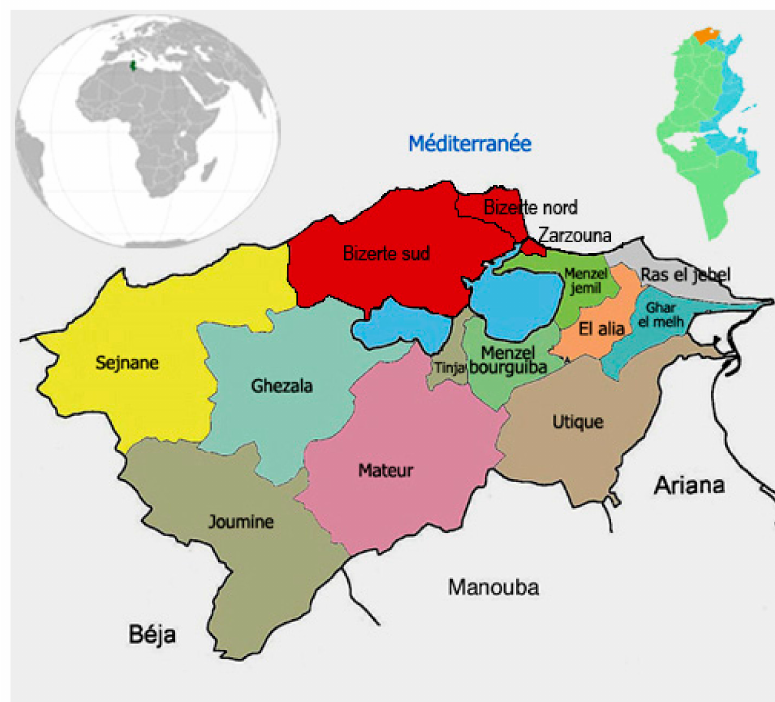
Figure 1. Map of Bizerte